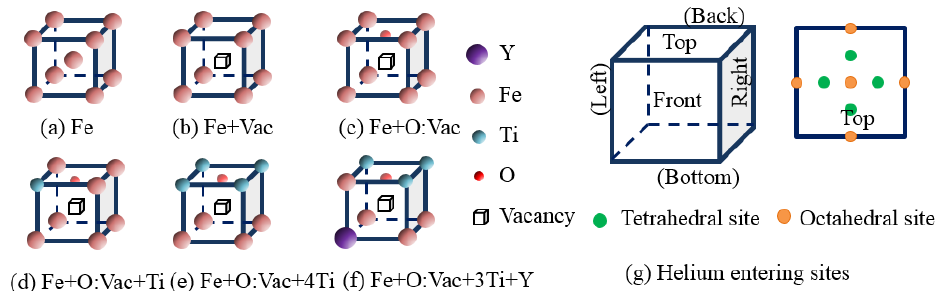
Figure 1. ( a )–( f ) Schematic atomic configuration of the reference units; ( g ) The possible entering sites of He on the reference unit during the He cluster growth. The six planes of the reference unit are named top, front, right, bottom, back and left. On each plane, the 5 octahedral sites and 4 tetrahedral sites are